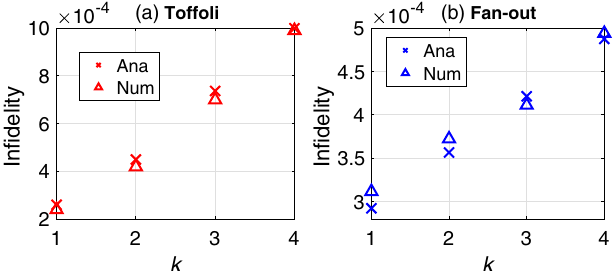
FIG. 8. Comparison of analytical and numerical error calcu- lations of multiqubit gates over a square optical lattice. In our numerical simulations, the Schrödinger equation is solved on the tensor product space of the atoms. The gates are operating on atoms populating neighboring positions in a square lattice with a lattice constant of 8 μ m. We assume an environment temperature of T ¼ 77 K and laser coupling strengths Ω t =B 1 ¼ 0 . 42 and Ω = 2 π ¼ 16 MHz, exciting the Rydberg states j 101 S; 109 S i ; see c Table I for the values of interaction Fan-out . — In the q th qubit configuration, with j q target atoms that are in the j 1 t i state, the first type of rotation error P j q q Þ 2 , Δ = Ω for the j 1 c i state is estimated by E ð l t Þ r 1 ¼ l ¼ 1 ð P j q D r l th atom where Δ l ¼ tt ð lm Þ is the level shift of the m ≠ l